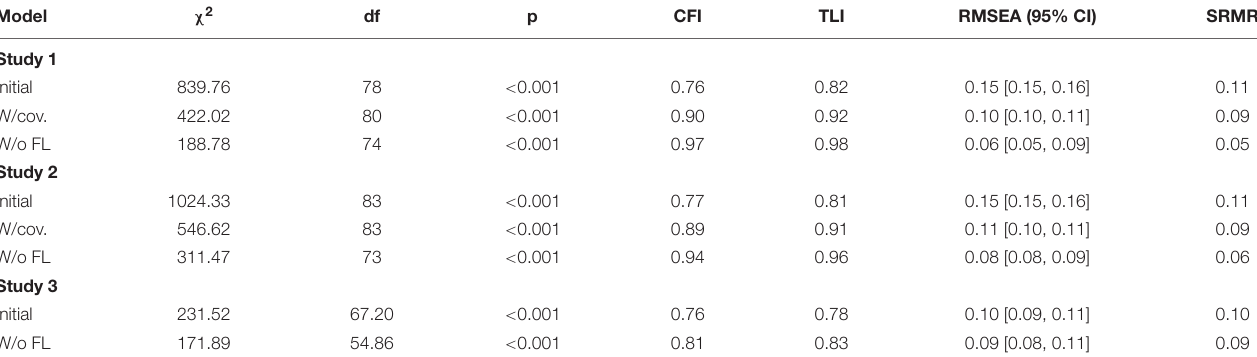
TABLE 2 | Model fit parameters of the tested models for all 3